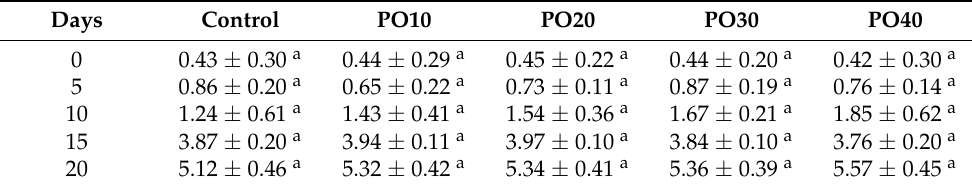
Table 9. Microorganisms of Pleurotus ostreatus (PO) pork sausages (log CFU/g). Days Control PO10 PO20 PO30 PO40 0 0.43 ± 0.30 a 0.44 ± 0.29 a 0.45 ± 0.22 a 0.44 ± 0.20 a 0.42 ± 0.30 a 5 0.86 ± 0.20 a 0.65 ± 0.22 a 0.73 ± 0.11 a 0.87 ± 0.19 a 0.76 ± 0.14 a 10 1.24 ± 0.61 a 1.43 ± 0.41